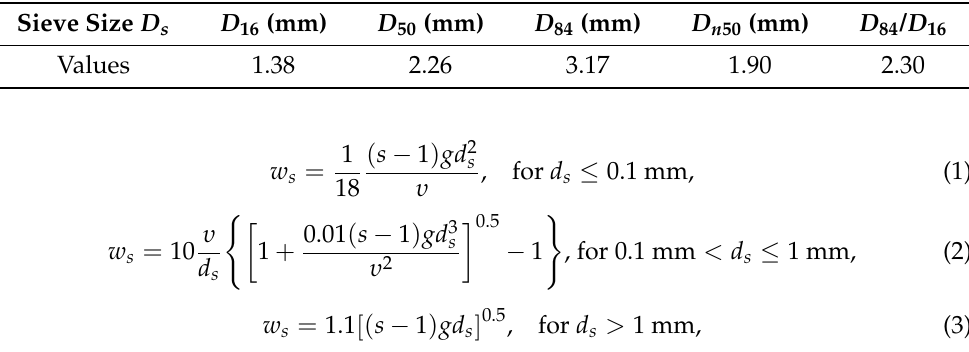
Table 3. Size and grading coefficient of applied armour